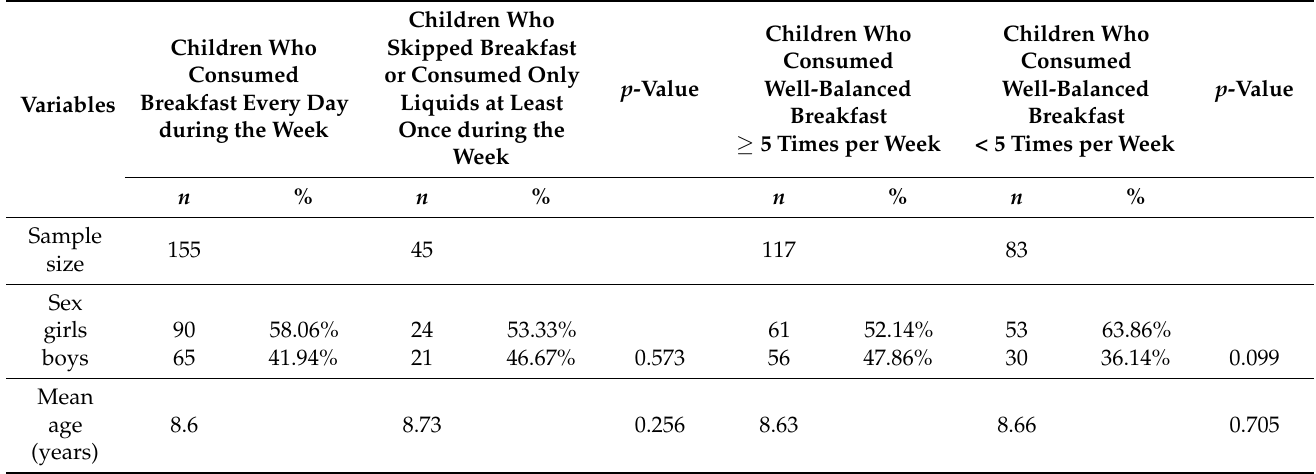
Figure 1. Regularity of breakfast consumption during a week in the group of 200 children. Table 2. Demographic characteristics of children different in everyday breakfast consumption and in the frequency of consumption of well-balanced breakfast.